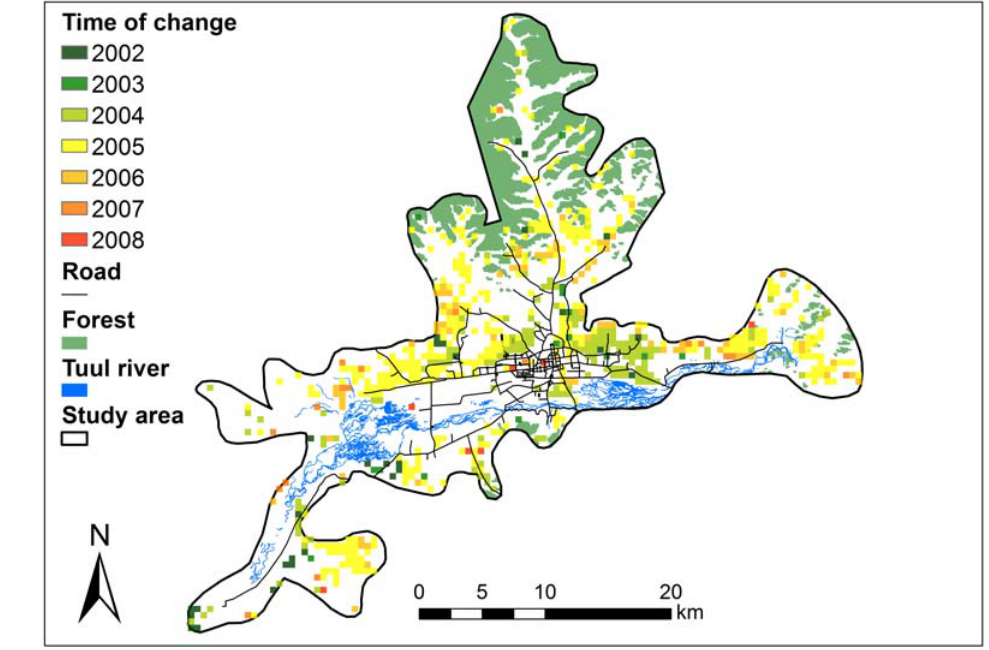
Figure 5. Spatial distribution of the timing of seasonal component change occurrences (showing only the first detected changes).